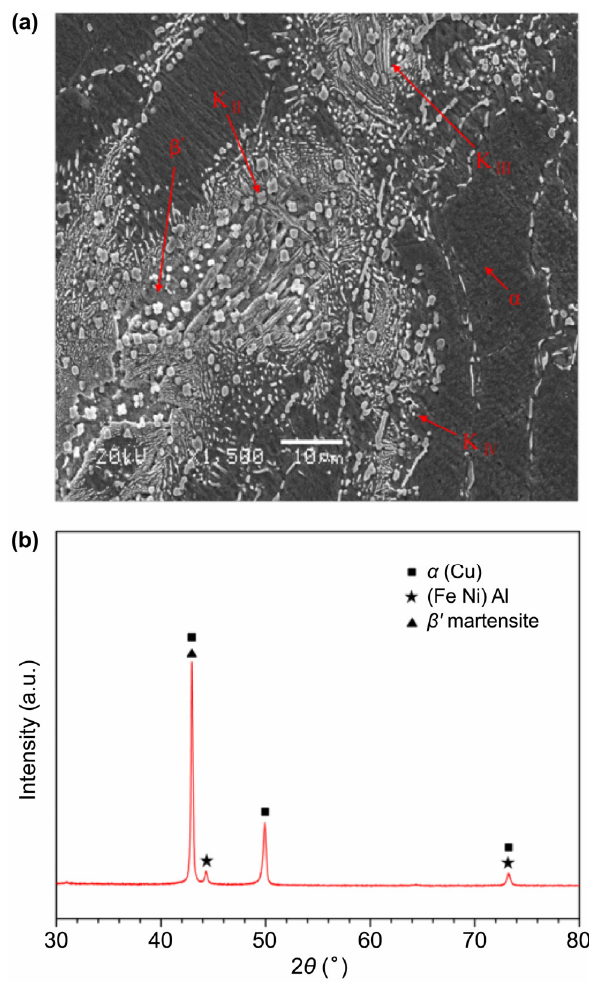
Fig. 1 SEM microstructure (a) and XRD pattern (b) of NAB alloy.